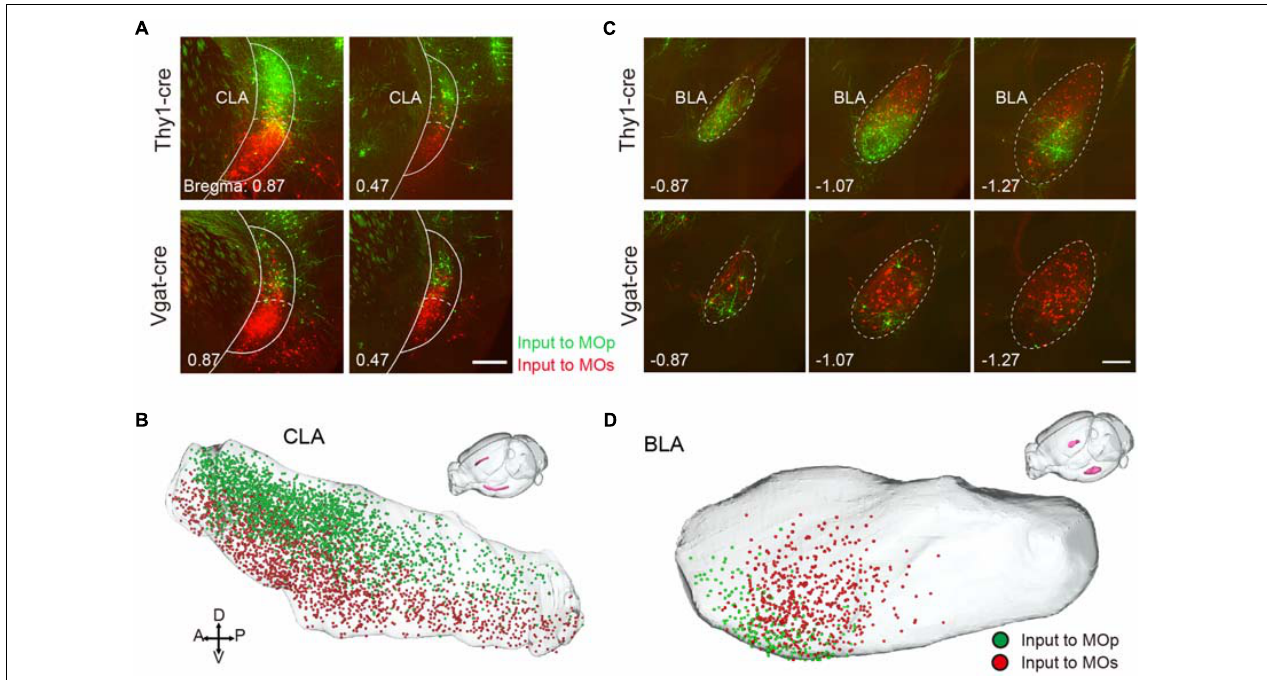
FIGURE 7 | Region-specific projection from CLA and BLA. (A) Distribution of input neurons to the MOp and MOs in the CLA. The green signal indicates the neurons projecting to the Mop, while the red signal indicates the neurons projecting to the MOs. Scale bar = 500 µ m. (B) Three-dimensional reconstruction of the CLA where green dots denote the neurons projecting to the MOp, while red dots denote the neurons projecting to the MOs. (C) Distribution of the input neurons to the MOp and MOs in the BLA. Scale bar = 500 µ m. (D) Three-dimensional reconstruction of the